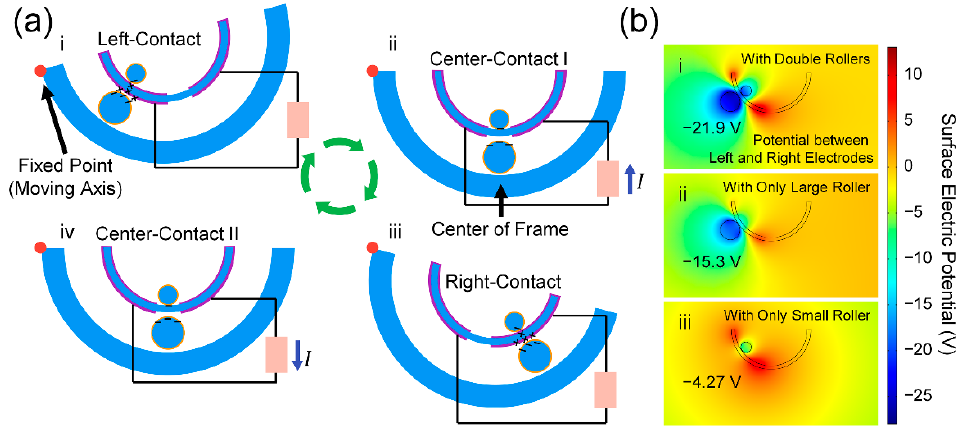
Figure 2. Working mechanism of the DR-TENG. ( a ) Operating principle of the DR-TENG with the double side-covered electrodes and double rollers. ( b ) Finite element method (FEM) simulation result indicating the surface electric potential with double rollers, only one large roller, and only one small roller.